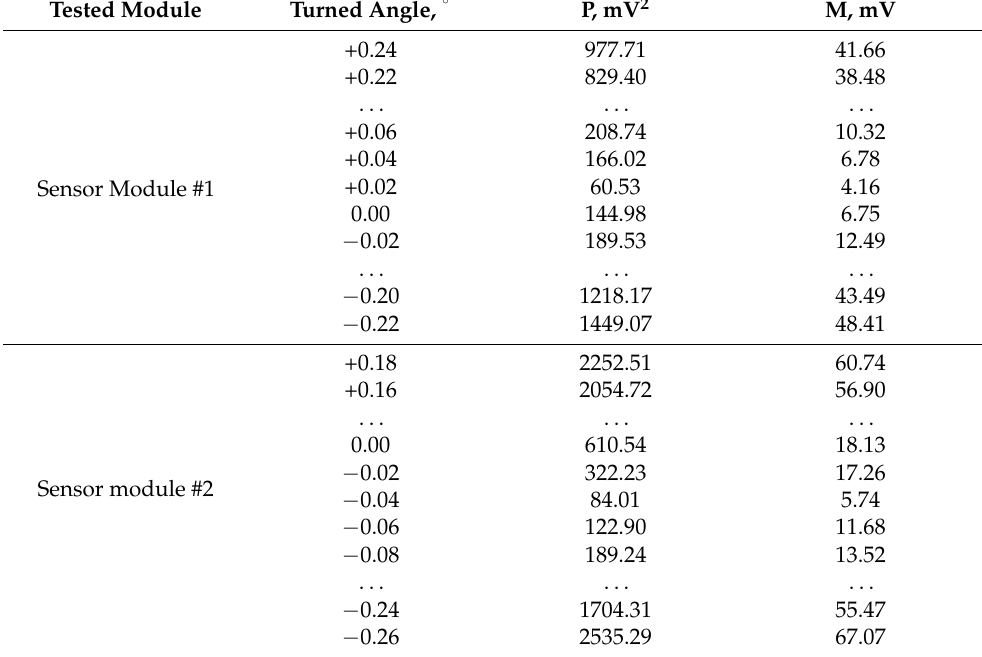
Table 2. Experimental